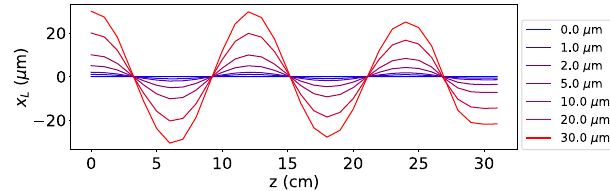
FIG. 4. Laser transverse position ¯ x 0 along propagation from W arp simulations. Colors represent different initial transverse positions between 0 and 30 μ m. Simulation conditions are given in Table